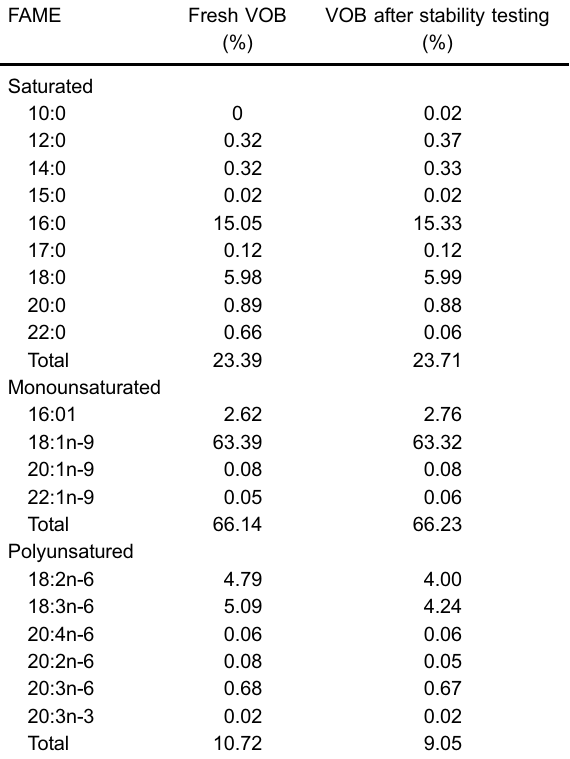
Table 1. Relative percentages of fatty acid methyl esters (FAME) in freshly prepared vegetable oil blend (VOB) and after stability